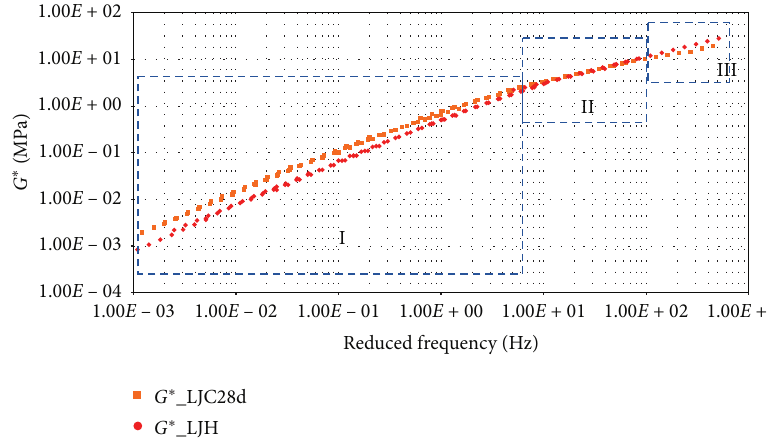
Figure 11: Master curves comparison between LJC28d and LJH. Table 6: J value of hot and cold nr